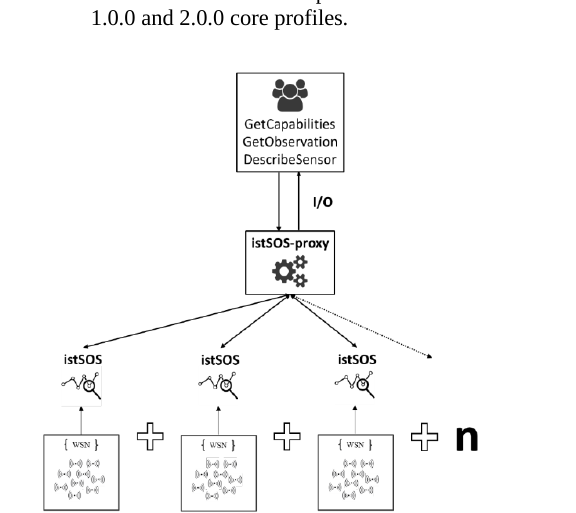
Figure 3. Schema of how istSOS-proxy works.